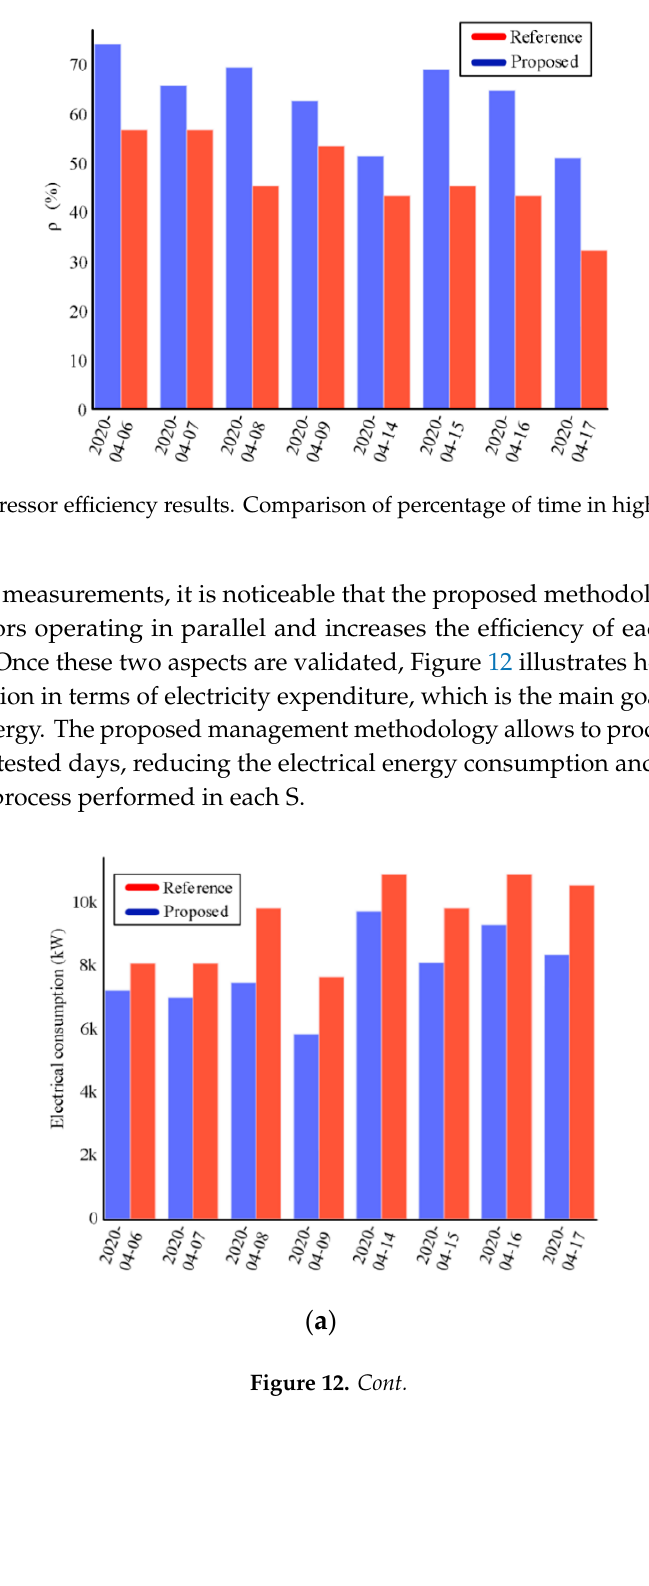
( c ) Figure 12. Electrical consumption results. ( a ) Electrical energy consumption of the proposed method compared with the reference. ( b ) Energy saved with the proposed method vs. reference. ( c ) Percentage of energy that it supposes. Observing such results, it can be concluded that the methodology demonstrates its effectivity reducing the energy expenditure of the compressors by reducing the simultaneity and increasing the PLR. By managing the evaporators of the system, hence the load, the compressors reduced its consumption per day about 1600 kWh, which means a reduction of about a 17% compared with the reference days. It is confirmed that the load management affects the compressors operation, since that they are able to supply the same 𝑄 with the expenditure of less electrical power, however, to fully ensure the effectiveness of the methodology, it is necessary to ensure that the temperature set points of each space to refrigerate are correctly maintained. There is no use in reducing the energy expenditure if the desired objective, which is the proper refrigeration of the products, is not achieved. Figure 13 depicts the mean temperature error of each day in each space to refrigerate. This error is only measured when the S are operating, since when there is no load in them, the refrigeration is stopped. According to experts, and following the historical control rules, each set point has 2 degrees of deadband, one above and one below the set point, where the temperature error is admissible. Nevertheless, the desired set point is depicted with a dashed line.